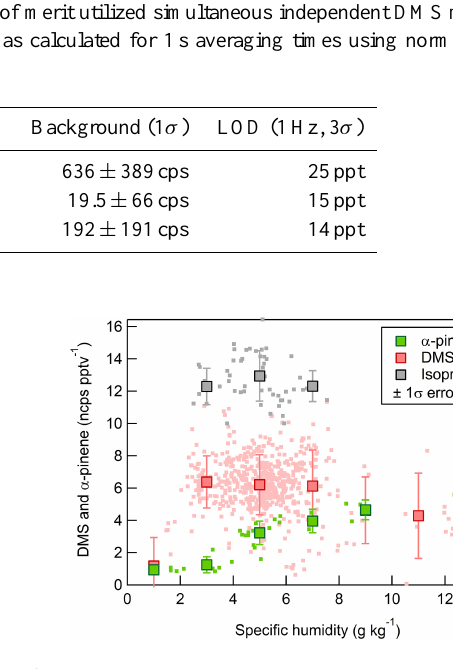
Figure 9. In-field sensitivities during standard additions as a func- tion of ambient specific humidity. Dots represent hourly values while squares represent mean values for a 2gkg − 1 specific humid- ity bin.